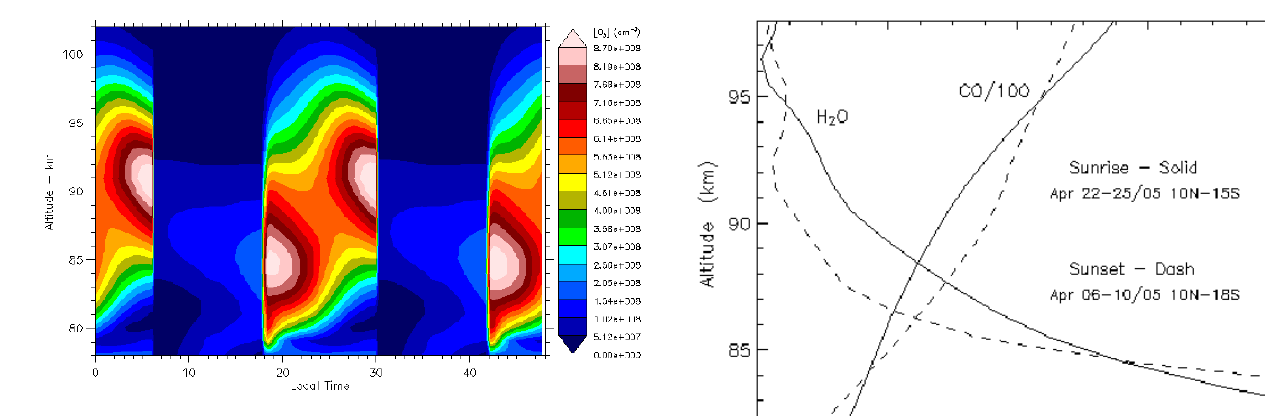
Fig. 4a. Local time variation of O 3 for model days seven through eight in the equatorial region for April. The effects of the diurnal tides are again evident. The large increase in O 3 just before sunrise is co-located with the diurnal temperature minimum and indicates the change in the O and O 3 partitioning with temperature.